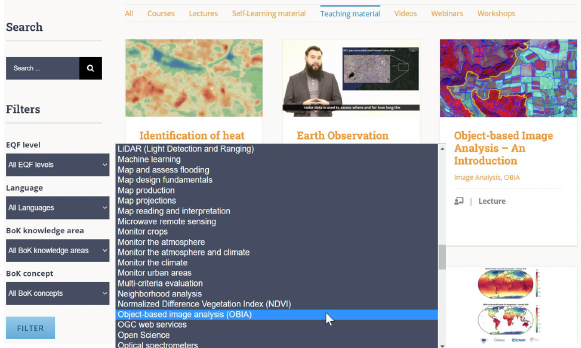
Figure 8 . Interface for searching training materials and training actions based on concepts in the EO4GEO BoK.